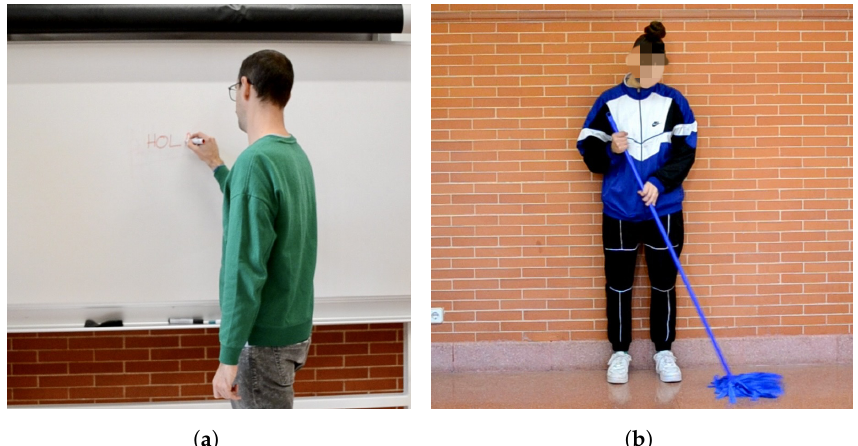
Figure 5. For this work, we have built a database with videos containing actors that execute, step by step, a set of actions of daily life that we want to work with patients. These images contain some captures where we can observe two actors performing two different actions. ( a ) The actor is showing the action of writing on the board. ( b ) The actor is showing the action of mopping the